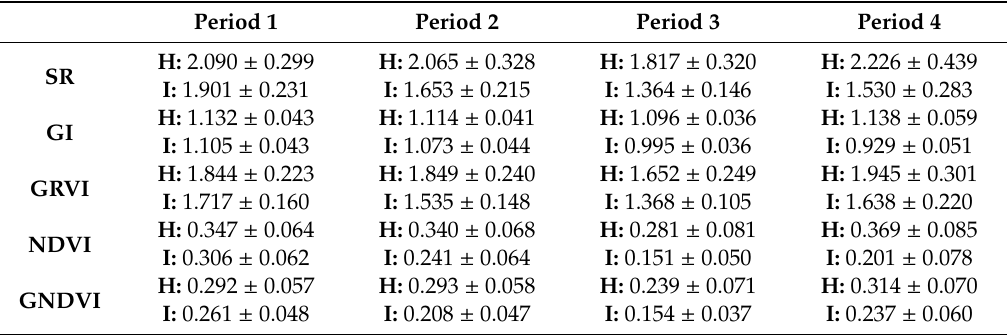
Table A1. Comparison of the variability of the training data reflectance values. H: represents training H-sample and I: training I-sample. First statistical value shows their mean, the second standard deviation for every used vegetation index and sensing period.